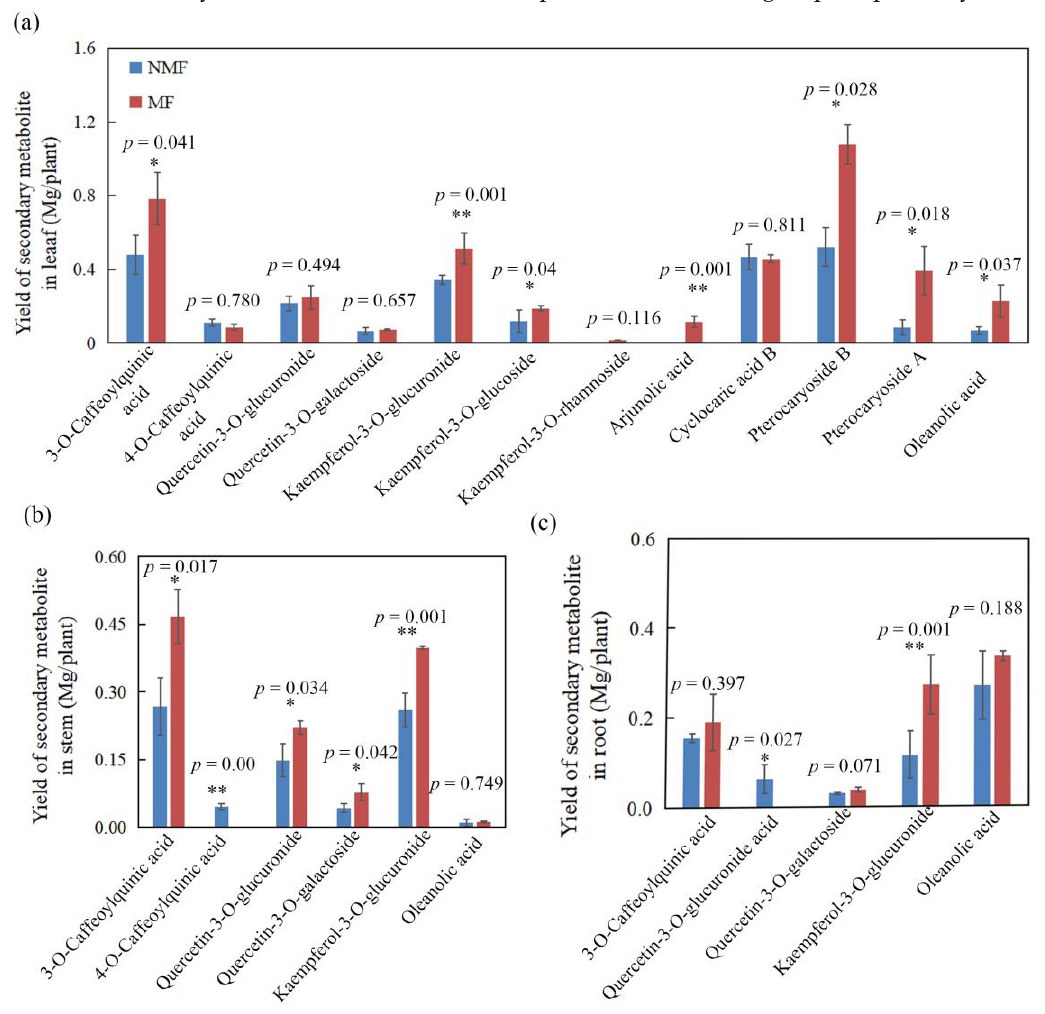
Figure 5. Influence of mycorrhizal fungal colonization on the yield of secondary metabolites per plant. ( a – c ) the yield of secondary metabolites in leaves, stems, and roots, respectively. * p < 0.05 and ** p < 0.01 indicate significant differences between inoculation and non-inoculation in two-tailed Student’ s tests.